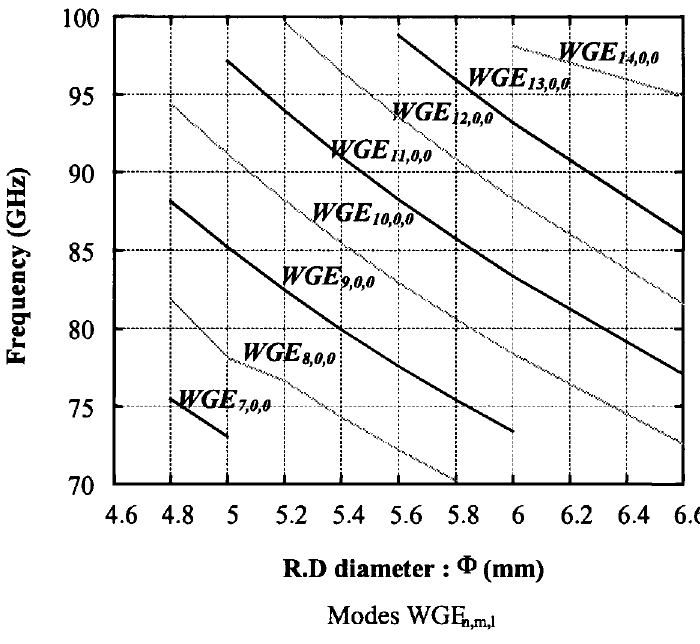
FIGURE 7 Theoretical graph showing the WGE family modes versus the resonator diameter.